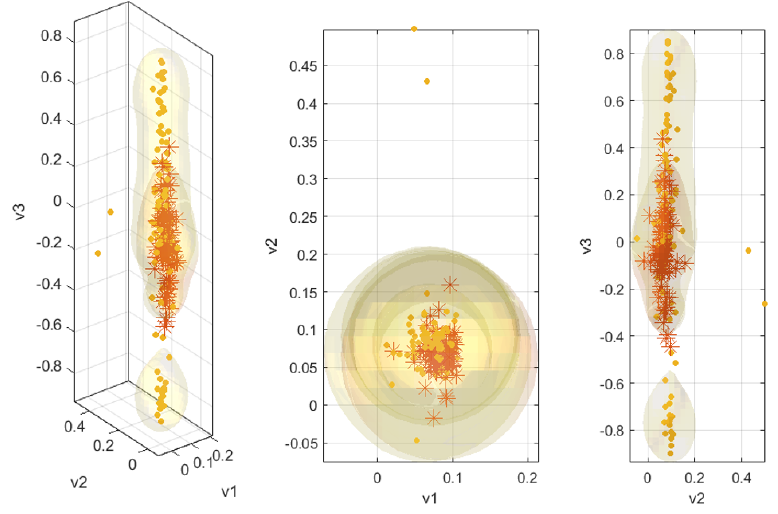
Figure 12. Plots of Police emergencies, the suspicious persons reported are represented in yellow points, and theft reported are represented with orange stars. By analyzing the information shown in the 3D and 2D plots, we infer that the two types of plotted emergencies are very closely related. With this information in mind, decision makers of this institution would consider dispatching personnel when they receive a report of suspicious persons, to prevent the commission crimes against the property or those in which the lives of the involved citizens may be